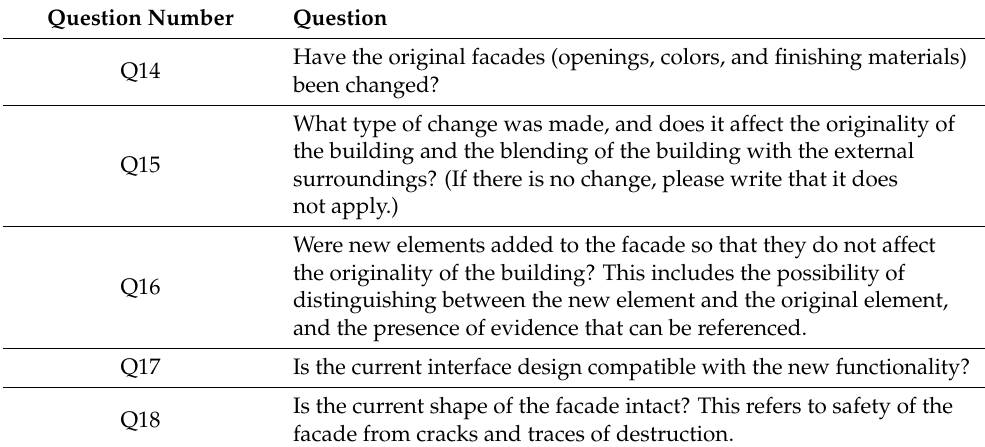
Table 4. Architectural design questions